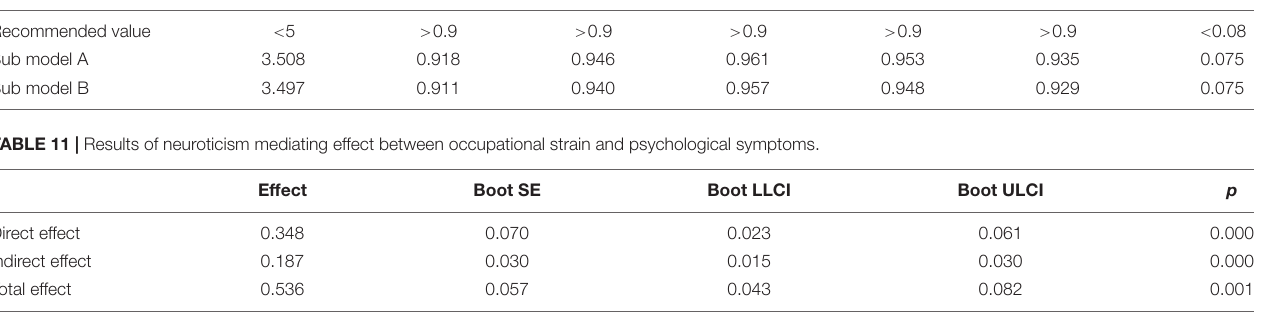
TABLE 10 | Model fitting index of occupational strain and neuroticism on psychological symptoms of metro drivers. Model fitting index